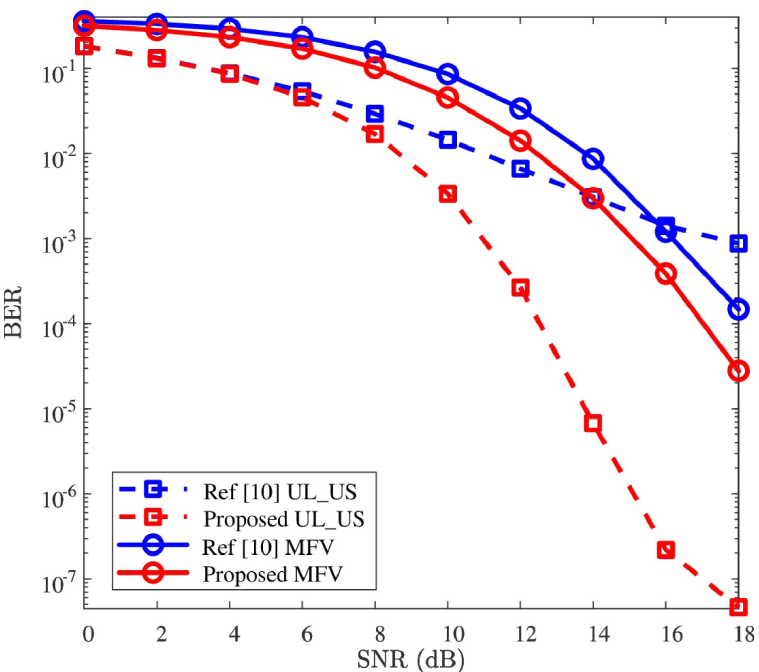
Fig 5. BER versus SNR, where P = 512, c = 2.0, and ρ = 0.10 are considered.